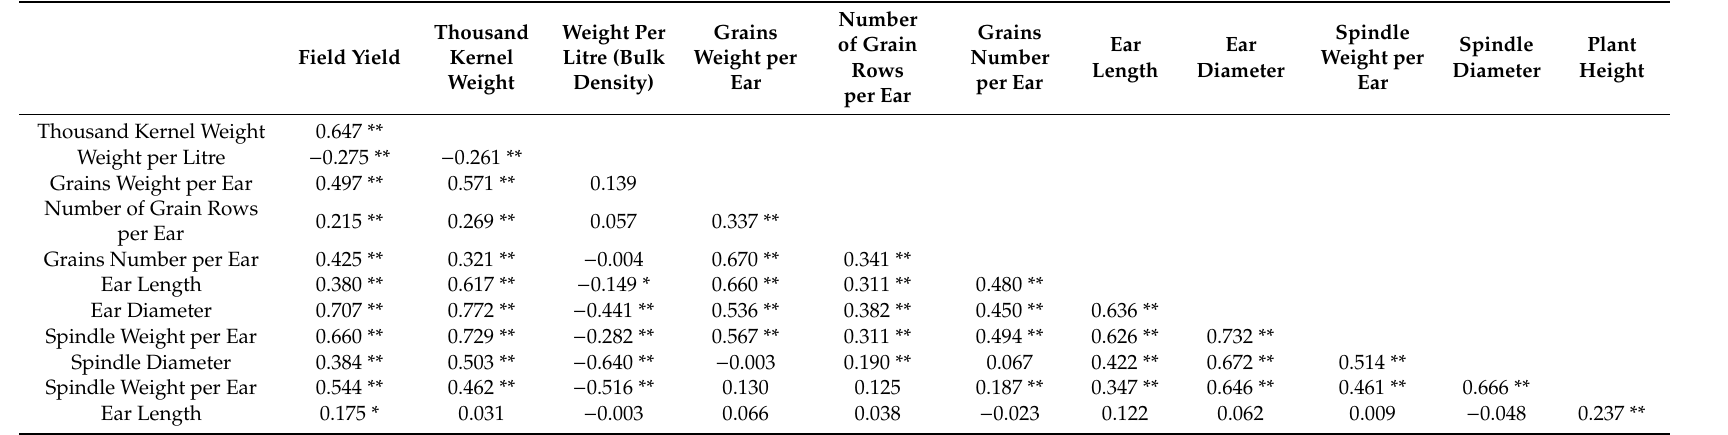
Table 3. Correlations between all characteristics (field yield, thousand kernel weight, weight per liter-bulk density, grains weight per ear, number of grain rows per ear, grains number per ear, ear length, ear diameter, spindle weight per ear, spindle diameter, plant height, ear emergence